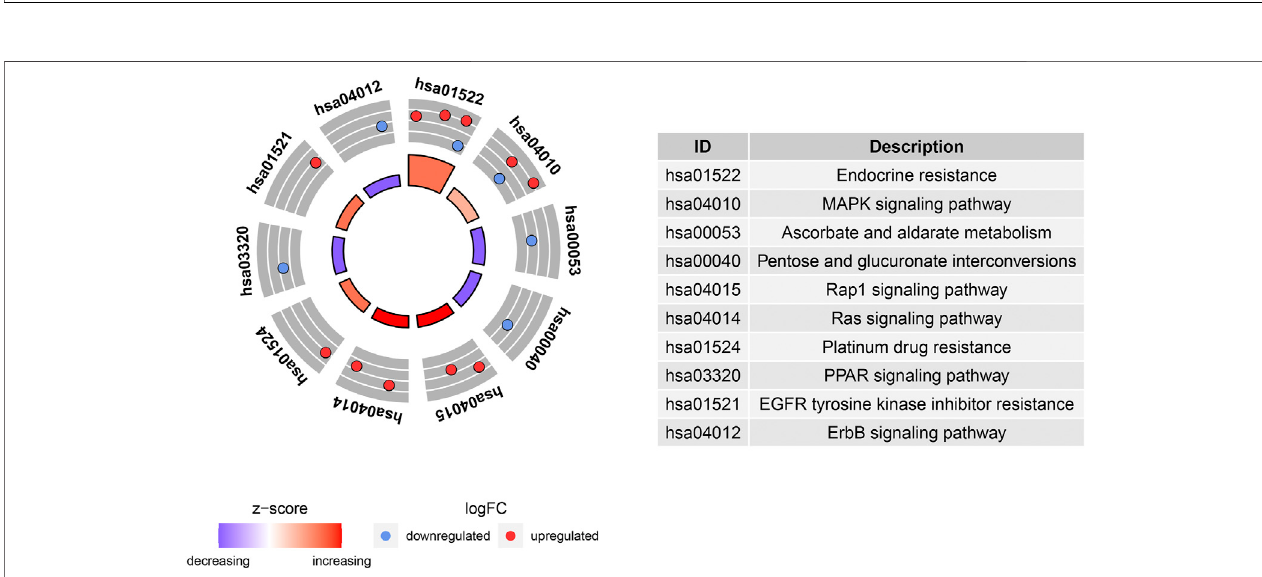
FIGURE 6 | Kyoto Encyclopedia of Genes and Genomes (KEGG) analysis of 16 differentially expressed aging-related genes.